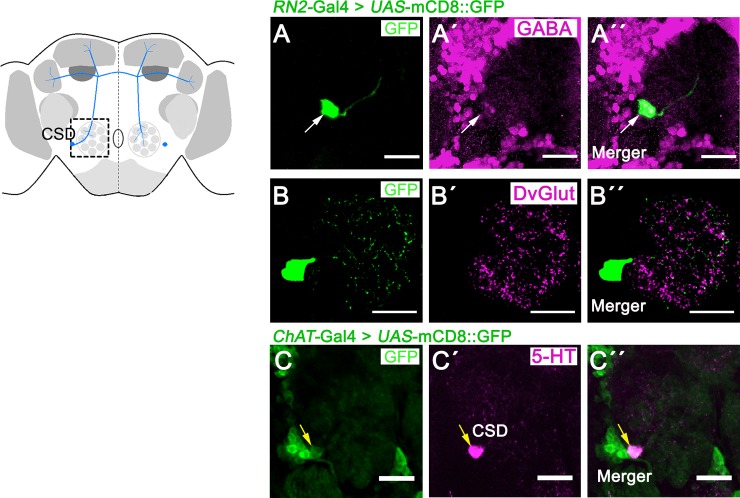
No co-localization of markers for GABA or glutamate in CSD neurons.A schema is provided indicating the region of interest–the antennal lobes- with a square. In A—C, the expression pattern of the RN2-Gal4 driver targeting CSD neurons are visualized using UAS-mCD8::GFP (in green). A—A´´, the cell bodies of CSD neurons (green) do not colocalize with GABA staining (in magenta) or, in the region of the ALs, B—B´´, with DvGlut (in magenta). C—C´´, the cholinergic neurons targeted by the ChAT-Gal4 driver (in green) co-express serotonin 5-HT (in magenta). A—C shows a representative 1-μm-thick slice of a confocal stack. The white arrow in A—A´´ indicates the position of CSD neurons in the adult brain, and the yellow arrows in C indicate co- expression of respective markers. Scale bars represent 25 μm.